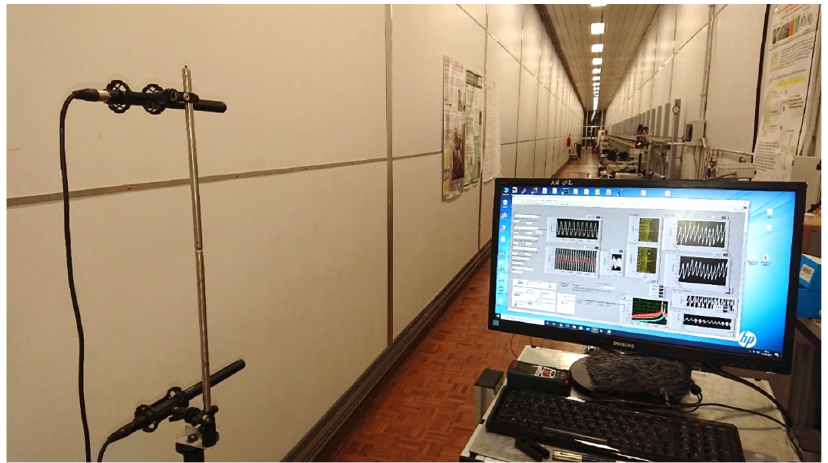
Figure 9. Picture of the experimental setup for the measurement of the vertical temperature gradient. In the foreground the two microphones and the screen of the LabView program used to analyze the data. The metrological gallery is 70 m long. Experiments at 60 m and at 26 m were performed successfully.